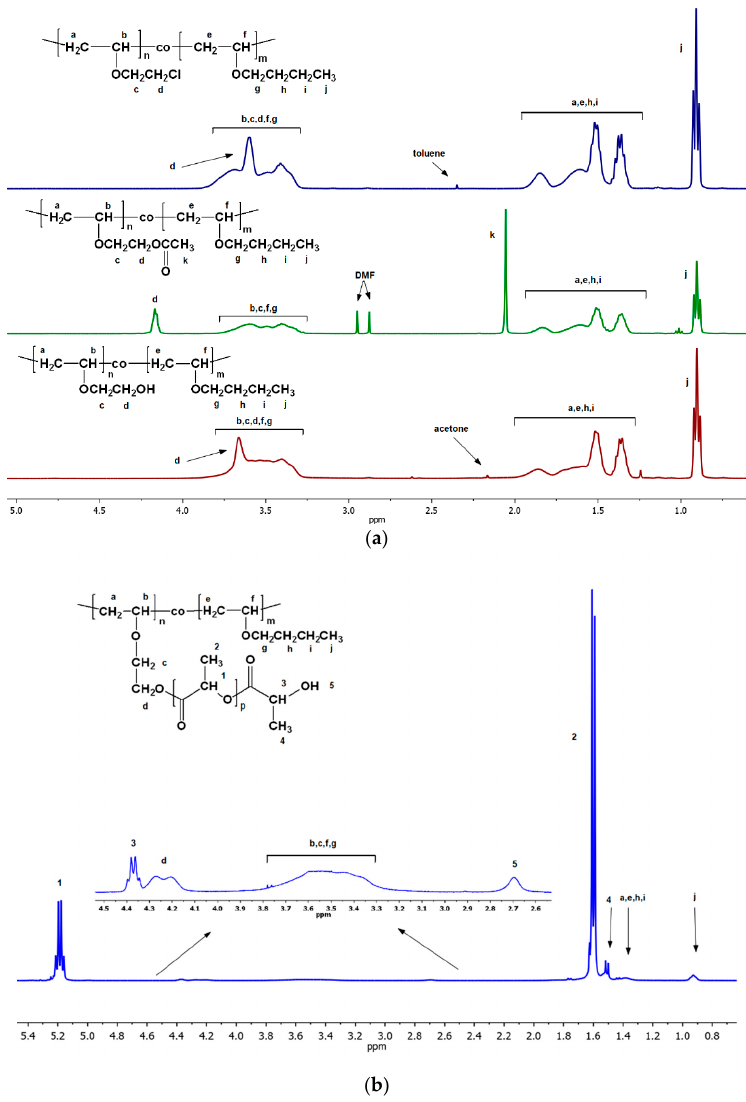
Figure 9. ( a ) Monitoring the synthesis of sample PBVE– g –PLLA #8 via the grafting “from” methodology by 1 H NMR spectroscopy in CDCl 3 ; ( b ) Monitoring the synthesis of sample PBVE– g –PLLA #8 via the grafting “from” methodology by 1 H NMR spectroscopy in CDCl 3 .